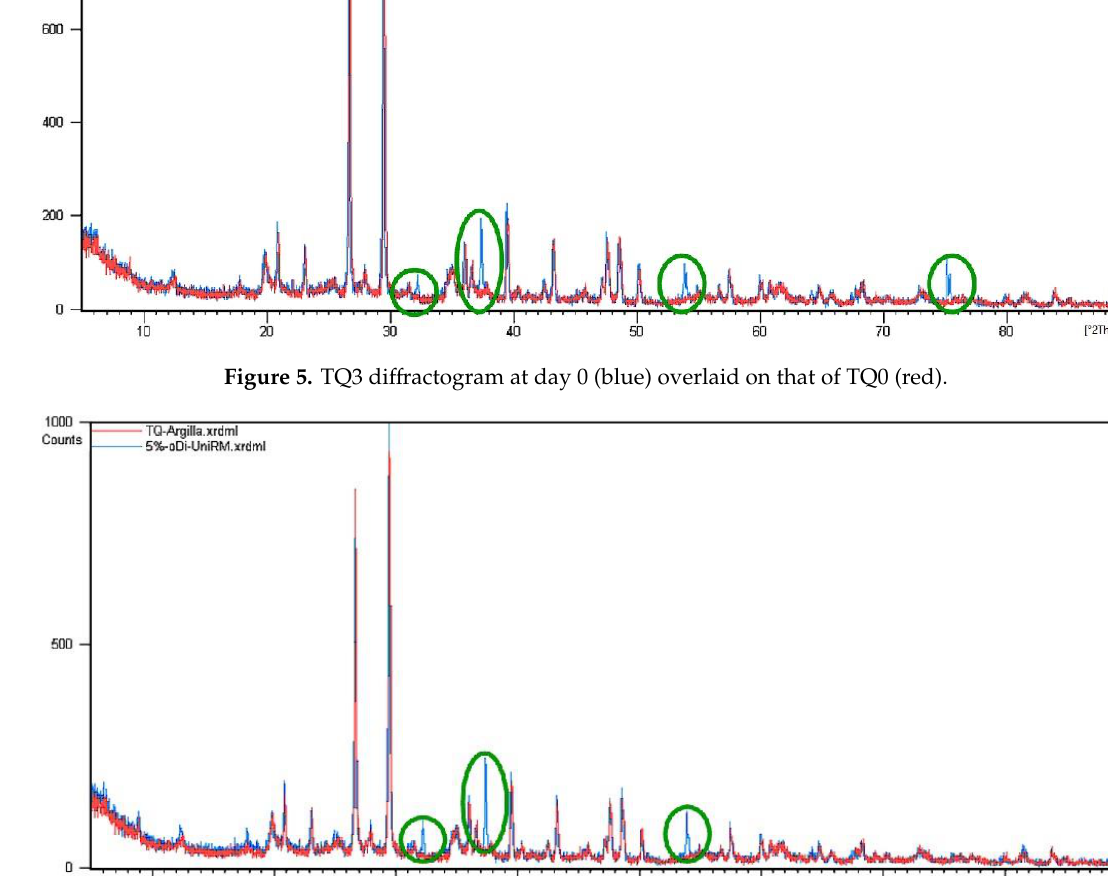
ff ractogram at day 0 (blue) overlaid on that of TQ0 Figure 6. TQ5 diffractogram at day 0 (blue) overlaid on that of TQ0 (red). Figure 6. TQ5 di Figure 6. TQ5 diffractogram at day 0 (blue) overlaid on that of TQ0 (red).